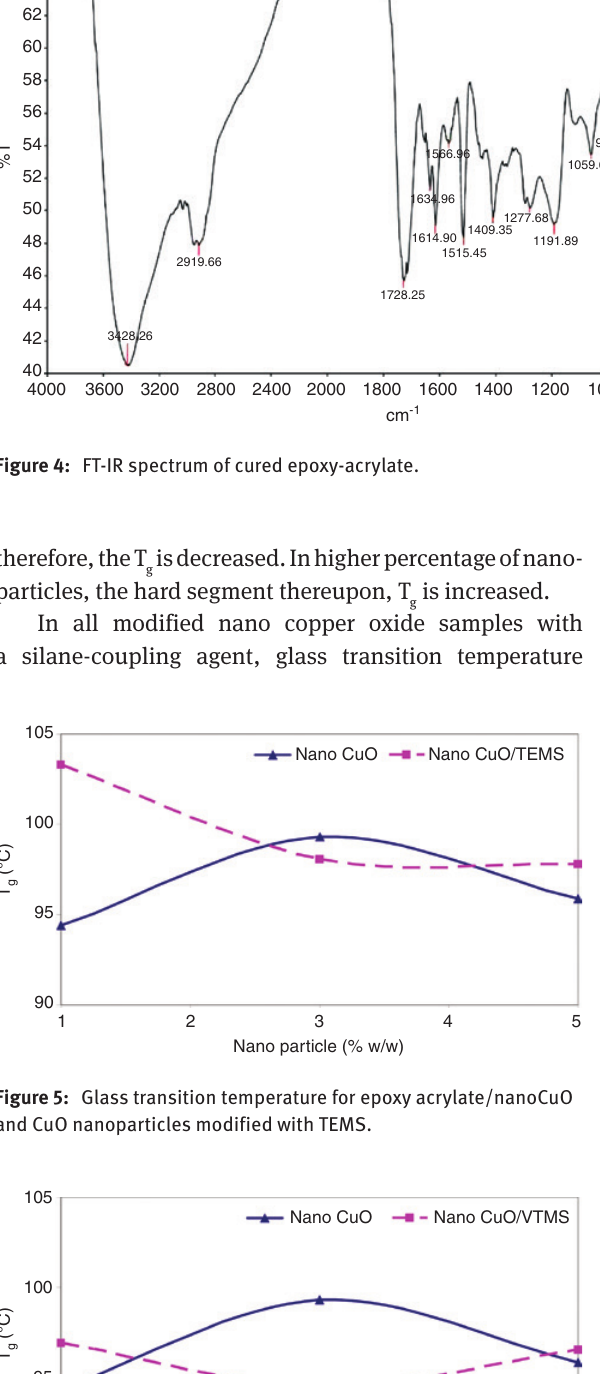
Figure 6: Glass transition temperature for epoxy acrylate/nanoCuO and CuO nanoparticles modified with VTMS.